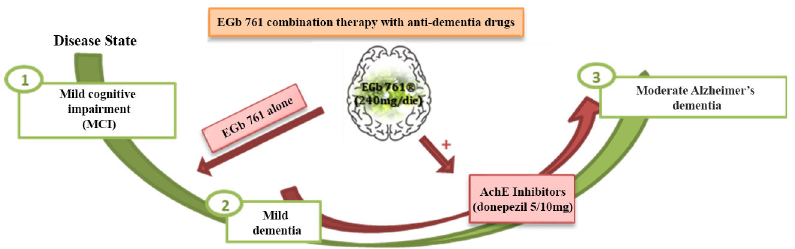
Figure 5. EGb 761 ® in association with anti-dementia